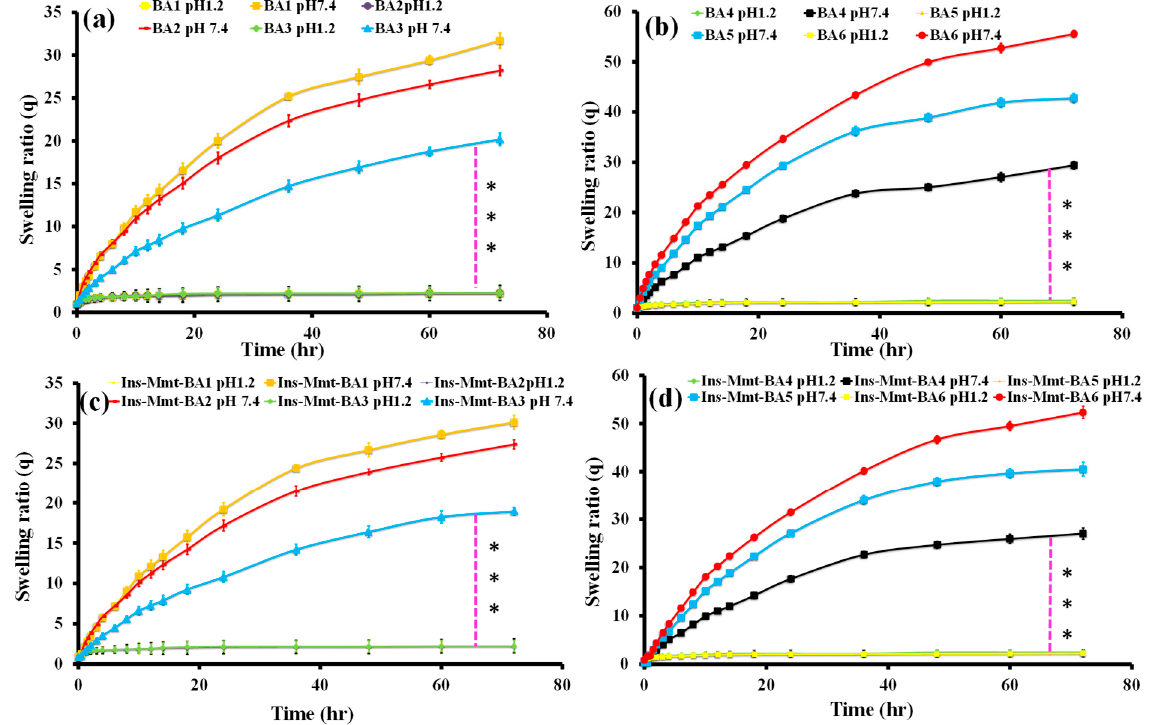
Figure 2. Swelling ratio ( q ) of all hydrogel (BA1-BA6) formulations ( a , b ) and all hydrogel NC (Ins- Mmt-BA1 to Ins-Mmt-BA6) formulations ( c , d ) at pH 1.2 and pH 7.4. (values are significantly different *** ( p < 0.001))